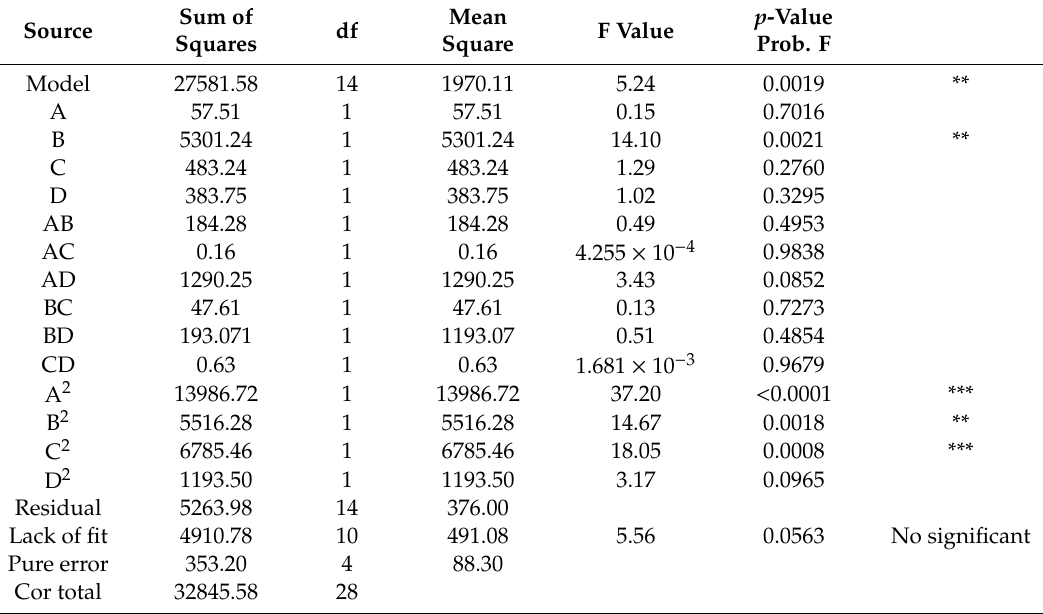
Table 2. Analysis of variance (ANOVA) for the fitted quadratic polynomial model for optimization of extraction